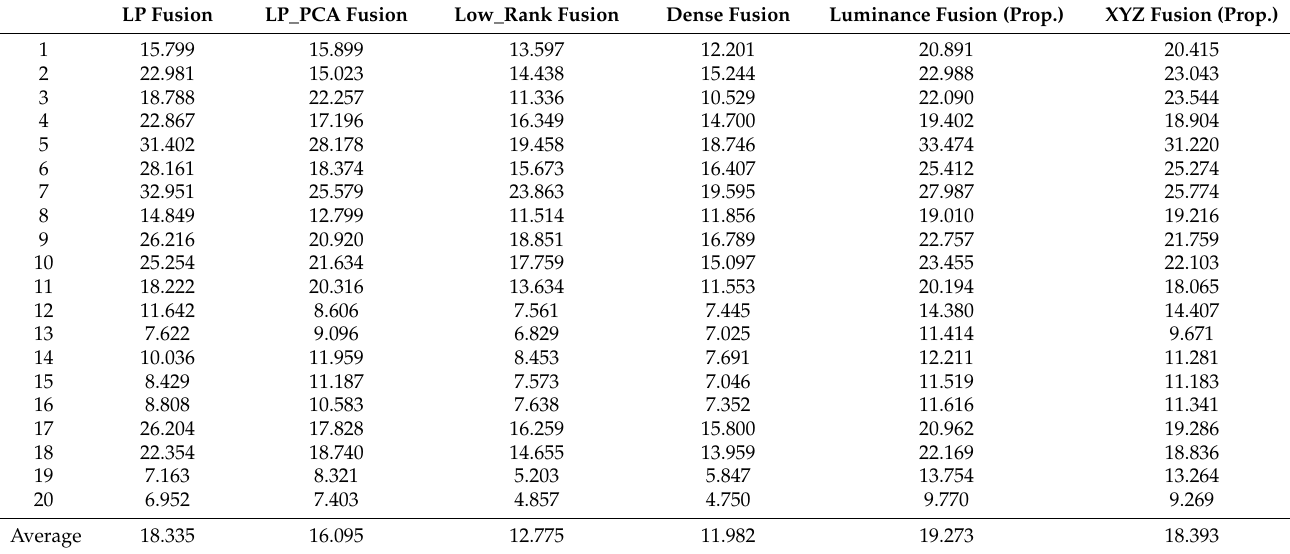
Table 9. Comparison of the Spatial frequency